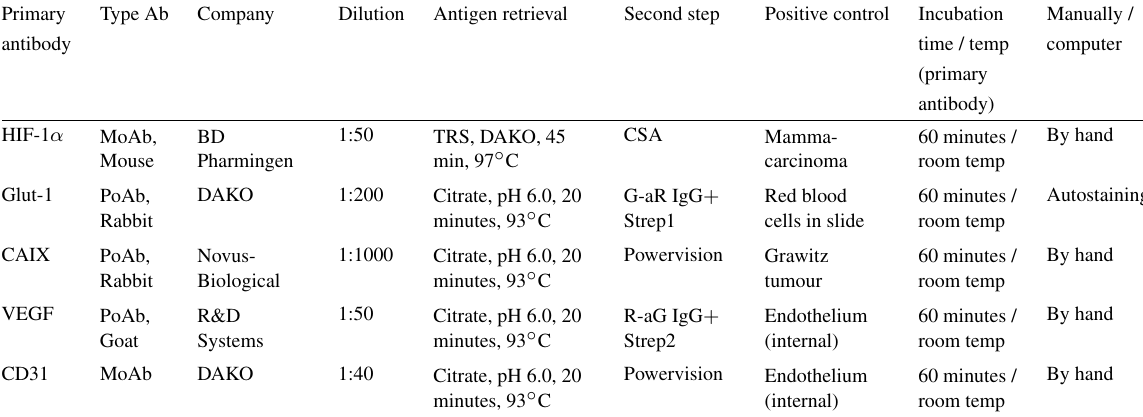
Overview of the antibodies used and tissue processing